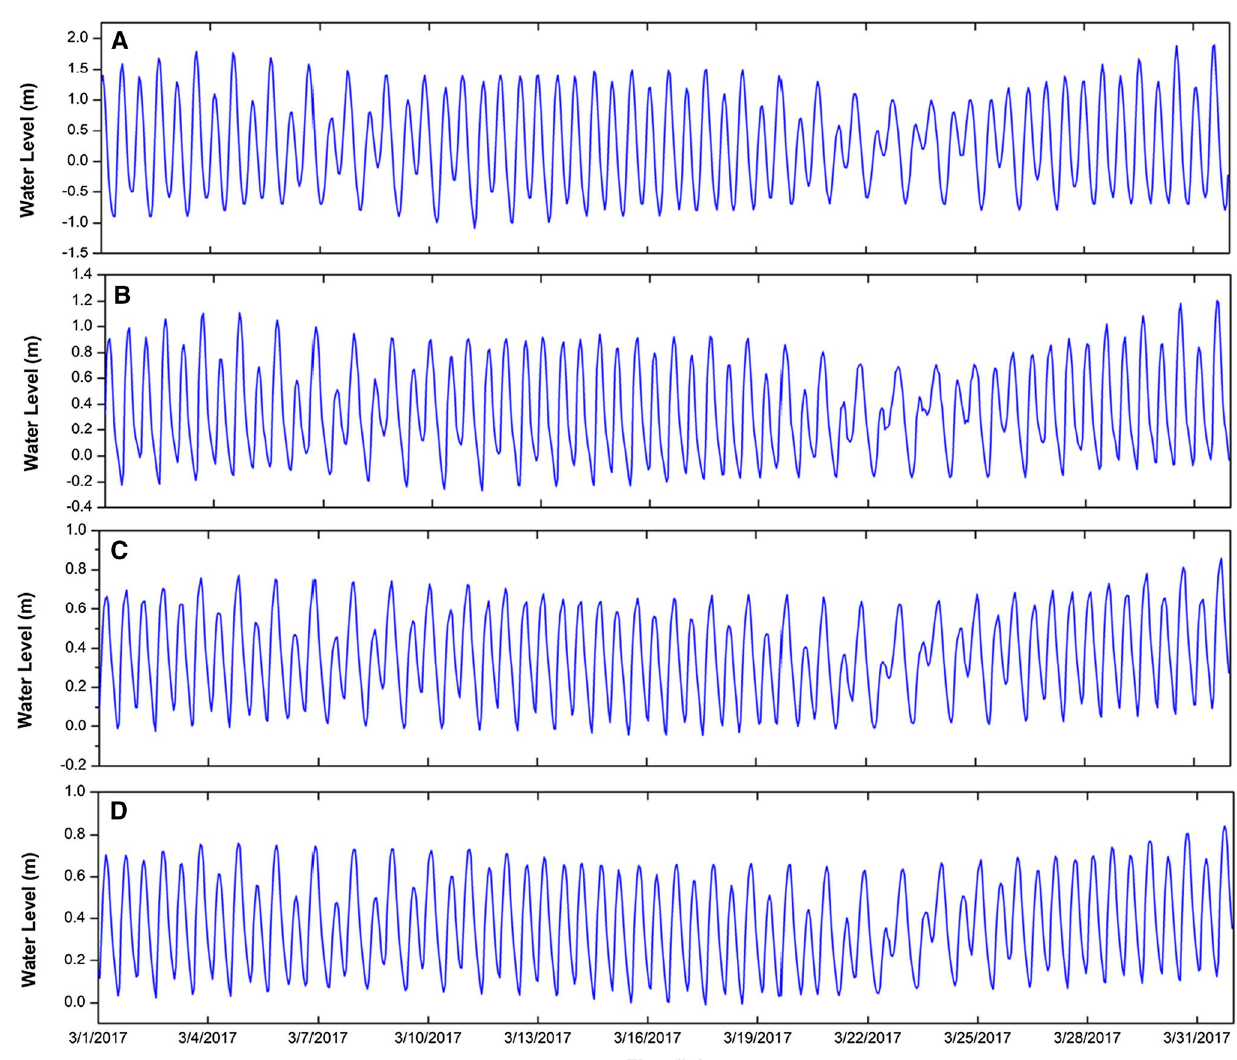
Fig. 3 Water level variations along the Shatt Al-Arab river estuary ( A : Faw, B : Sihan, C : Abo Flous, D : Basrah